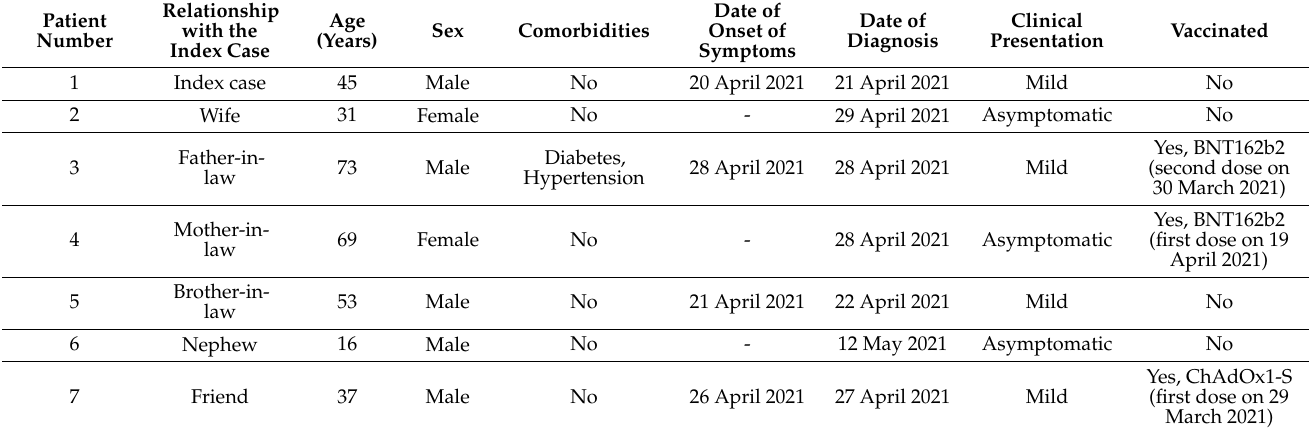
Table 1. Demographic and clinical characteristics of seven cases of SARS-CoV-2 P.1 variant infections. Patient